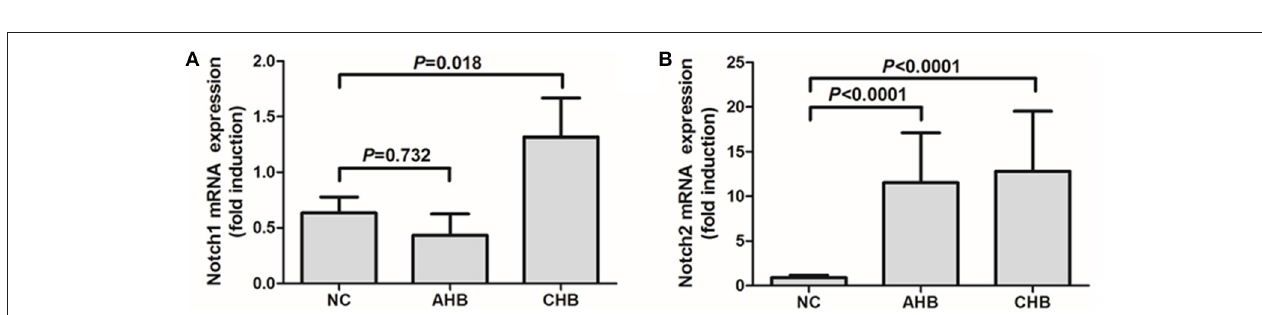
FIGURE 4 | Inhibition of Notch signaling blocked the recruitment of antigen-non-specific cells into the liver. IHLs were isolated and analyzed by flow cytometry. (A) CD3 + CD4 + cells. (B) CD3 + CD4 − NK1.1 − cells. (C) CD3 − NK1.1 + cells. (D) CD3 + NK1.1 + cells. All values are presented as the average from each group, and error bars represent SE.